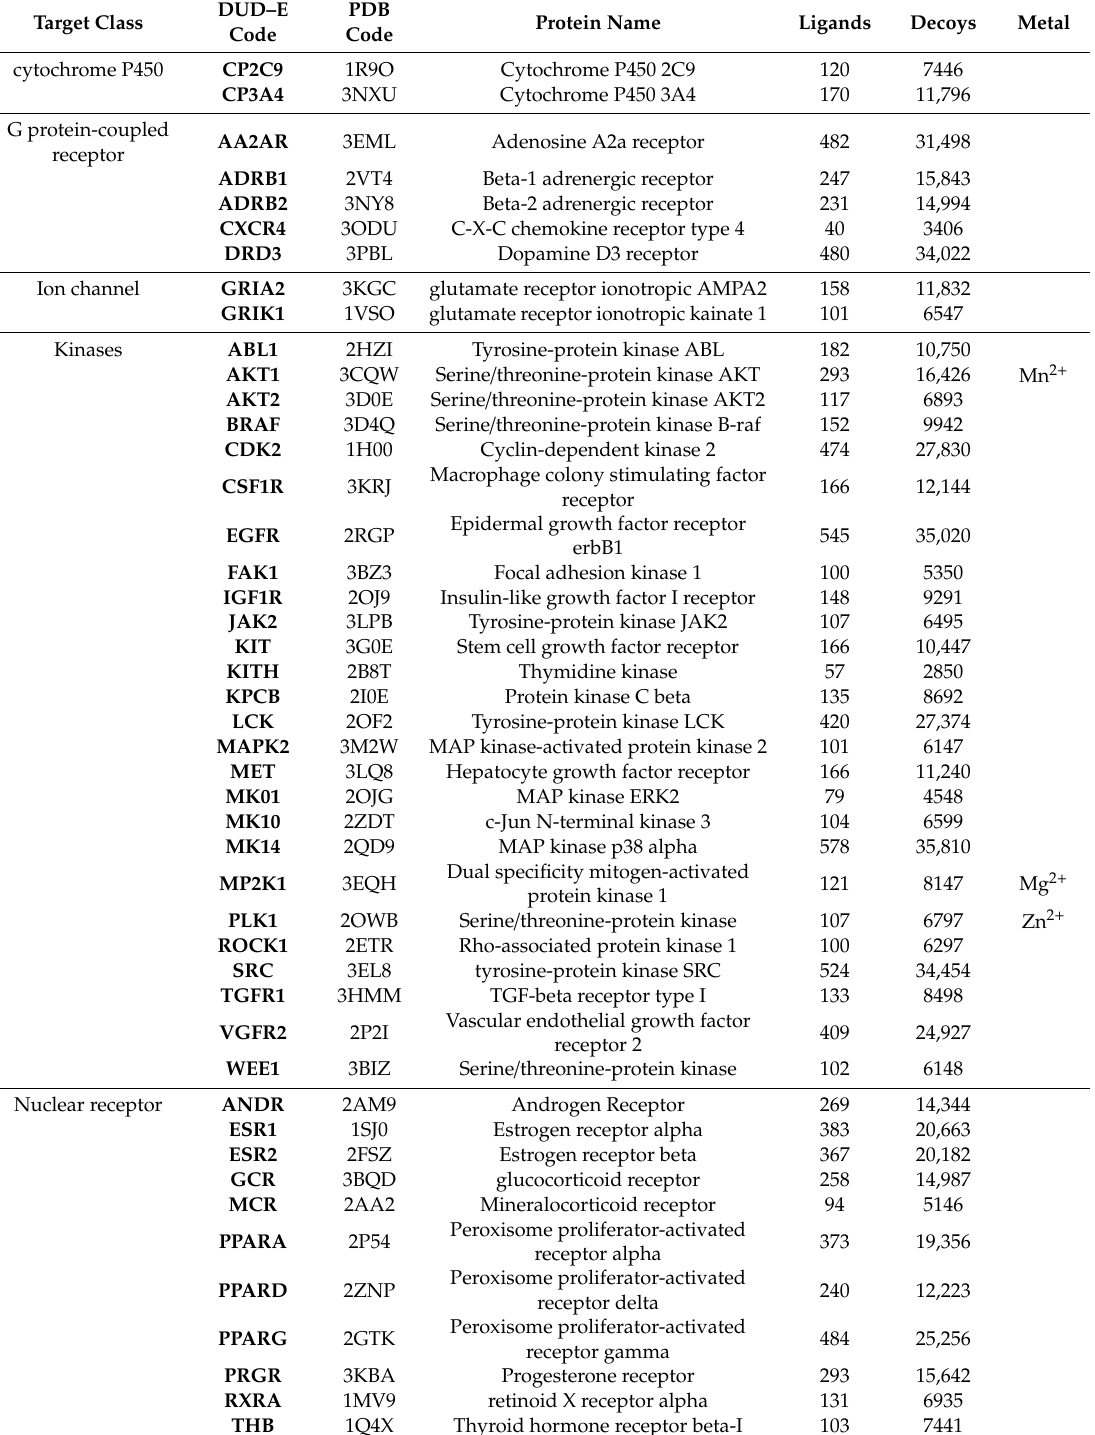
Table 1. Protein targets evaluated in this study as part of DUD–E with indication of the di ff erent classes of targets